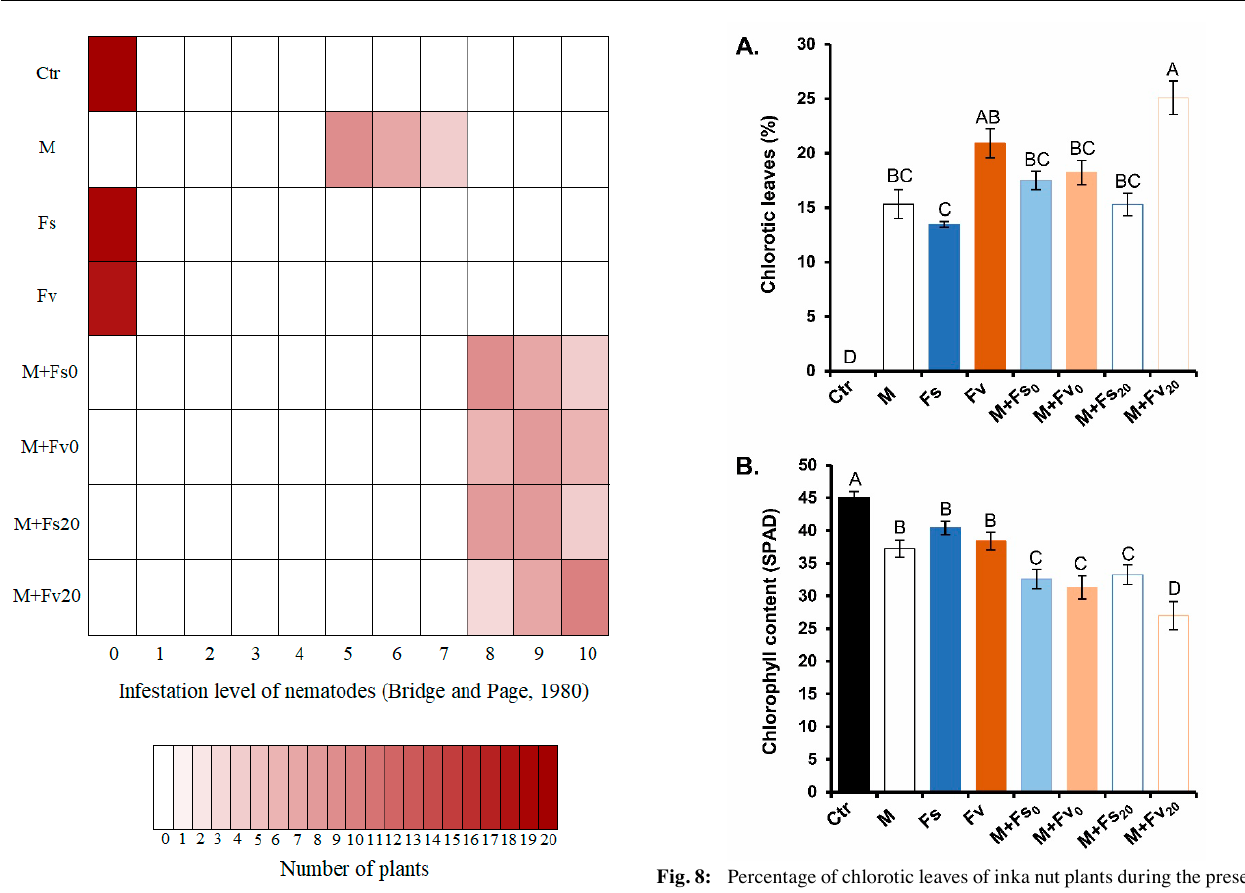
Fig. 7: Heat map showing the infection level of nematodes ( B RiDgE and P agE , 1980) of the treatments under